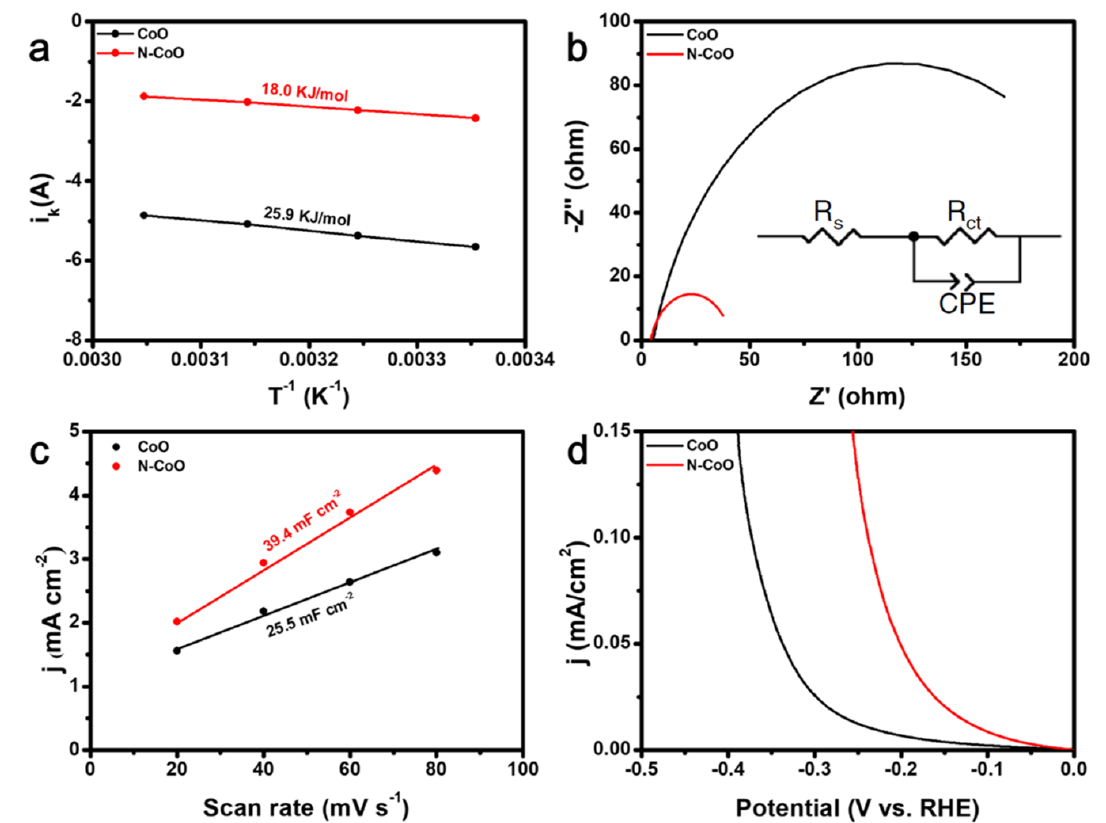
Figure 5. ( a ) Arrhenius plots of the kinetic current at an overpotential of 200 mV for the CoO and N-CoO nanowires. ( b ) EIS of the CoO and N-CoO nanowires. The inset is an equivalent circuit of the CoO and N-CoO nanowires. ( c ) ECSA of the CoO and N-CoO nanowires. ( d ) TOF of the CoO and N-CoO nanowires.